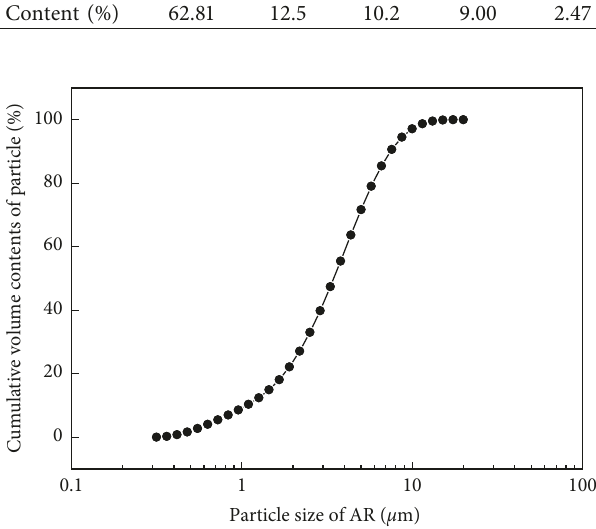
Figure 2: Curves of particle size analysis of AR.